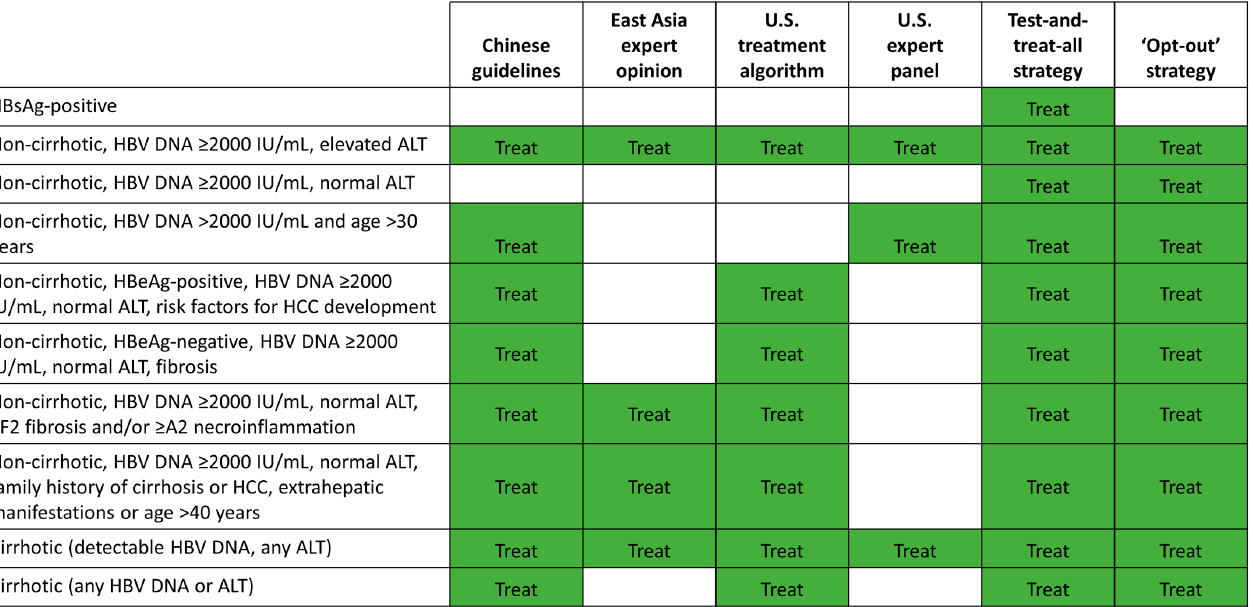
Figure 4. Potential expanded HBV treatment strategies. This figure summarizes the categories of CHB patients who would be eligible for antiviral treatment initiation under the proposed alternative treatment strategies. The Chinese guidelines [75], East Asian expert opinion [61], U.S. treatment algorithm [84] and U.S. expert panel [85] recommend initiation of antiviral treatment in more CHB patients compared with the current EASL, APASL, or AASLD guidelines, but include different patient subpopulations. The test-and-treat-all strategy would initiate antiviral treatment in all HBsAg- positive patients. The ‘opt-out’ strategy would initiate antiviral treatment in all cirrhotic patients and non-cirrhotic adult patients with HBV DNA ≥ 2000 IU/mL regardless of HBeAg and ALT status. AASLD, American Association for the Study of Liver Diseases; ALT, alanine aminotransferase; APASL, Asian Pacific Association for the Study of the Liver; CHB, chronic hepatitis B; EASL, European Association for the Study of the Liver; HBeAg, hepatitis B envelope antigen; HBsAg, hepatitis B surface antigen; HBV, hepatitis B virus; HCC, hepatocellular carcinoma.